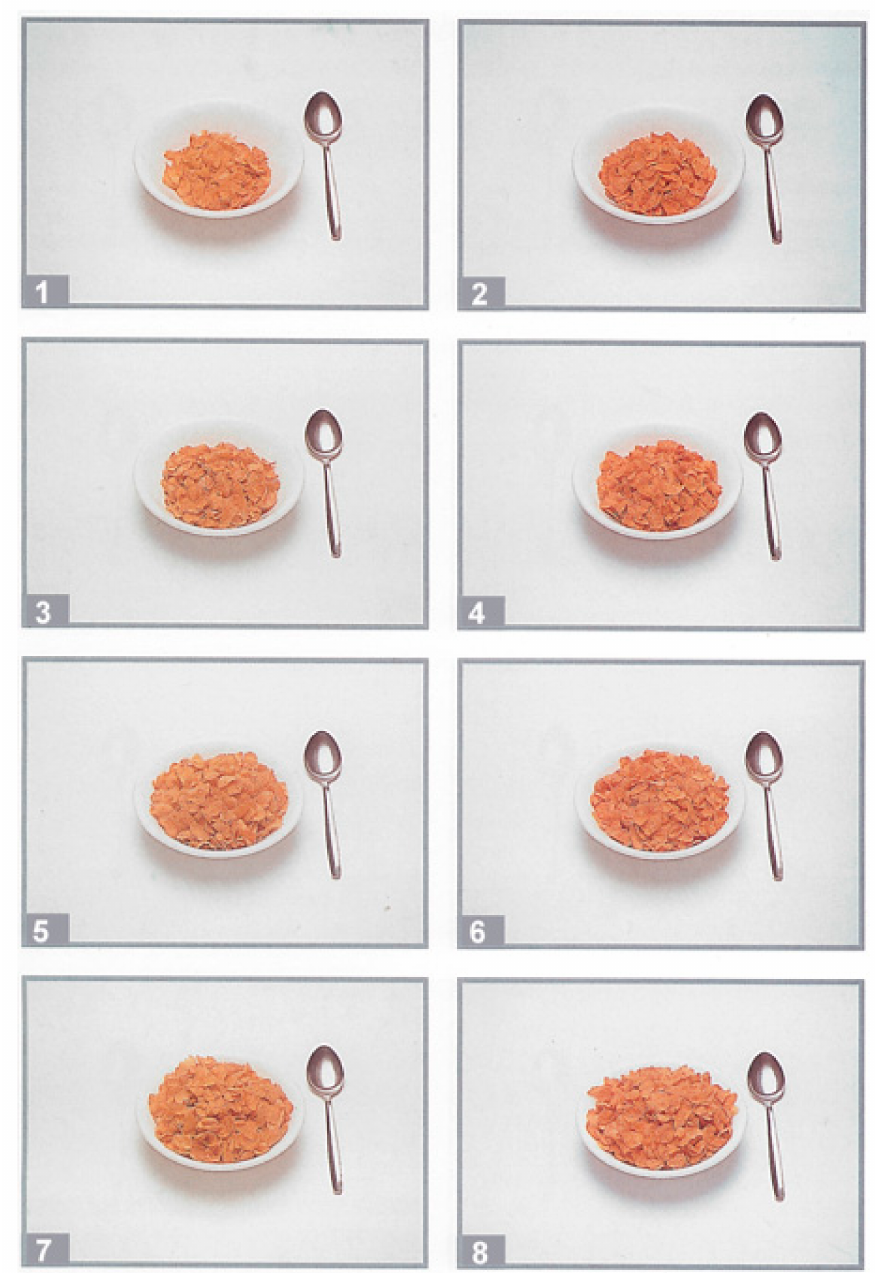
Figure 2. Example of portion size selection show card used in survey for cereal. Taken from validated food atlas